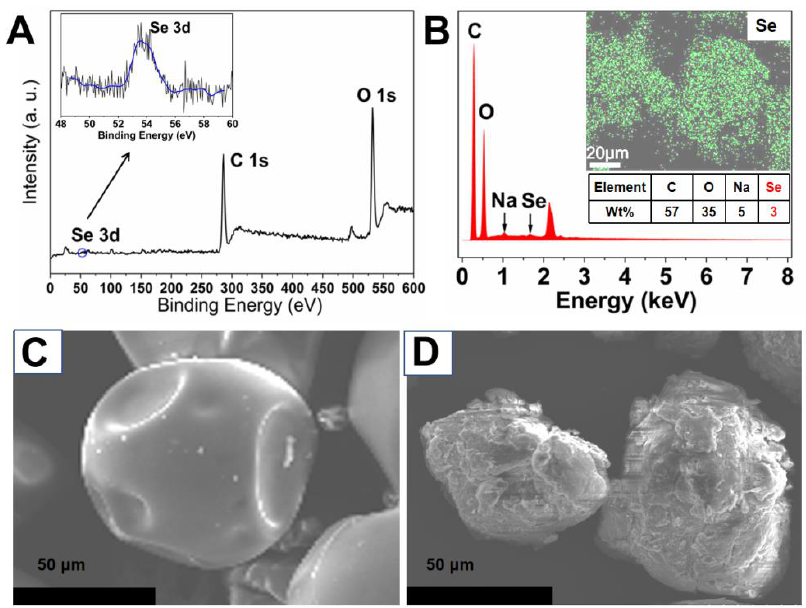
Figure 2. XPS spectrum ( A ), EDS spectrum and Se map of Se-starch80 ( B ); SEM images of OSA starch ( C ) and Se-starch80 ( D ).